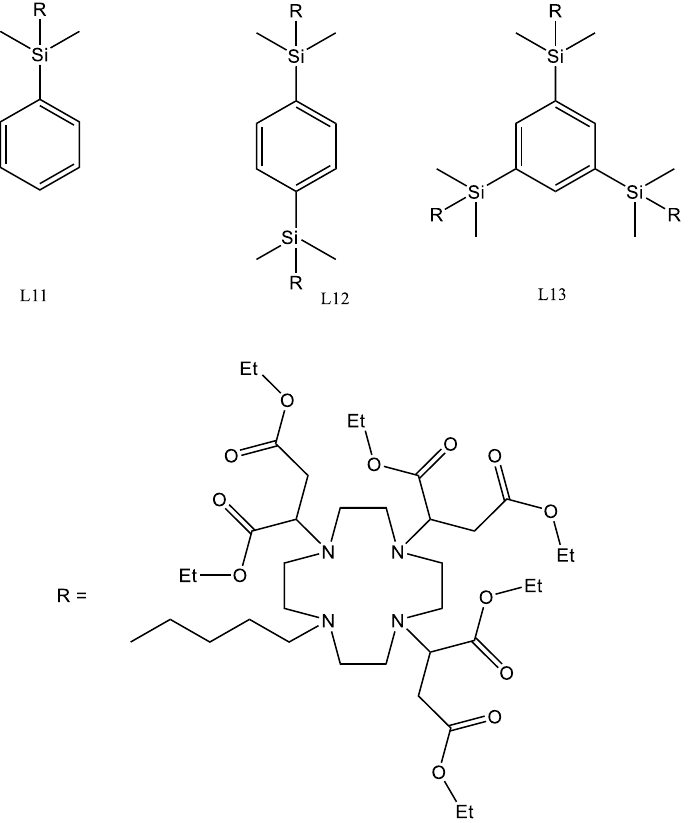
Figure 4. Mono-, di-, and tri- substituted silyl benzenes as scaffolds for cyclen ligands.